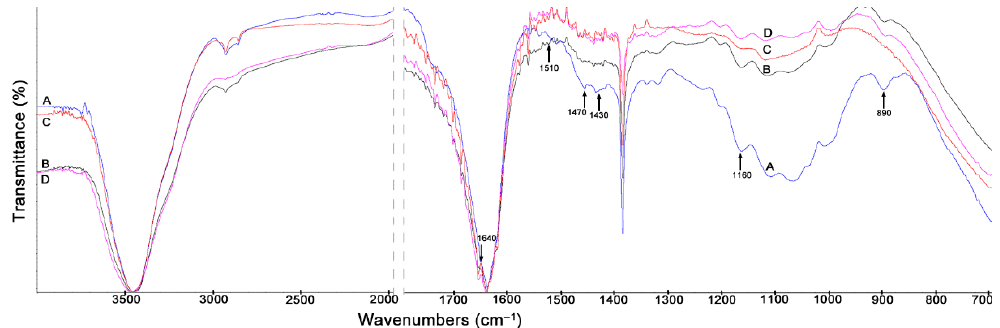
Figure 6. FTIR spectra of cellulose isolated from maize stover fractions: ( A ) cobs, ( B ) husks, ( C ) leaves, ( D ) stalks. In the FTIR spectra of lignin isolated from the maize stover fractions (Figure 7), a very